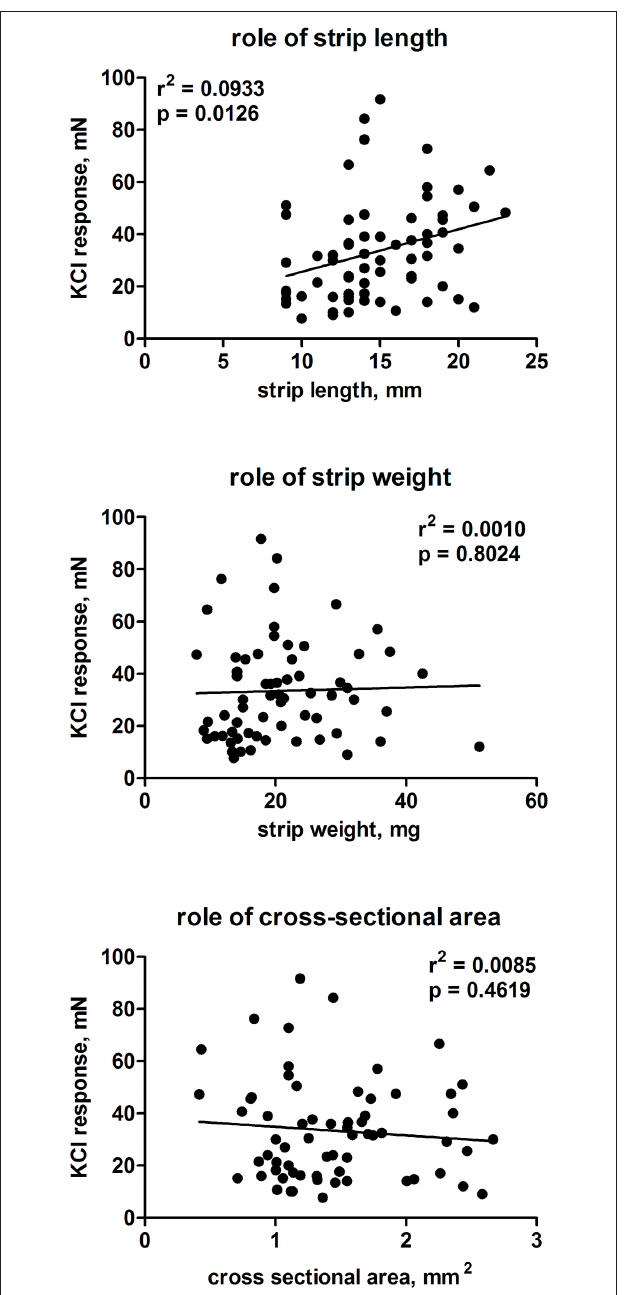
Figure 1 | role of normalization of contractile responses to 50 mM KCl based upon strip length (upper panel), weight (middle panel), or calculated cross-sectional area (lower panel). Each data represents one strip (in total 66 strips from 30 patients), and data obtained on days 0–2 were included.